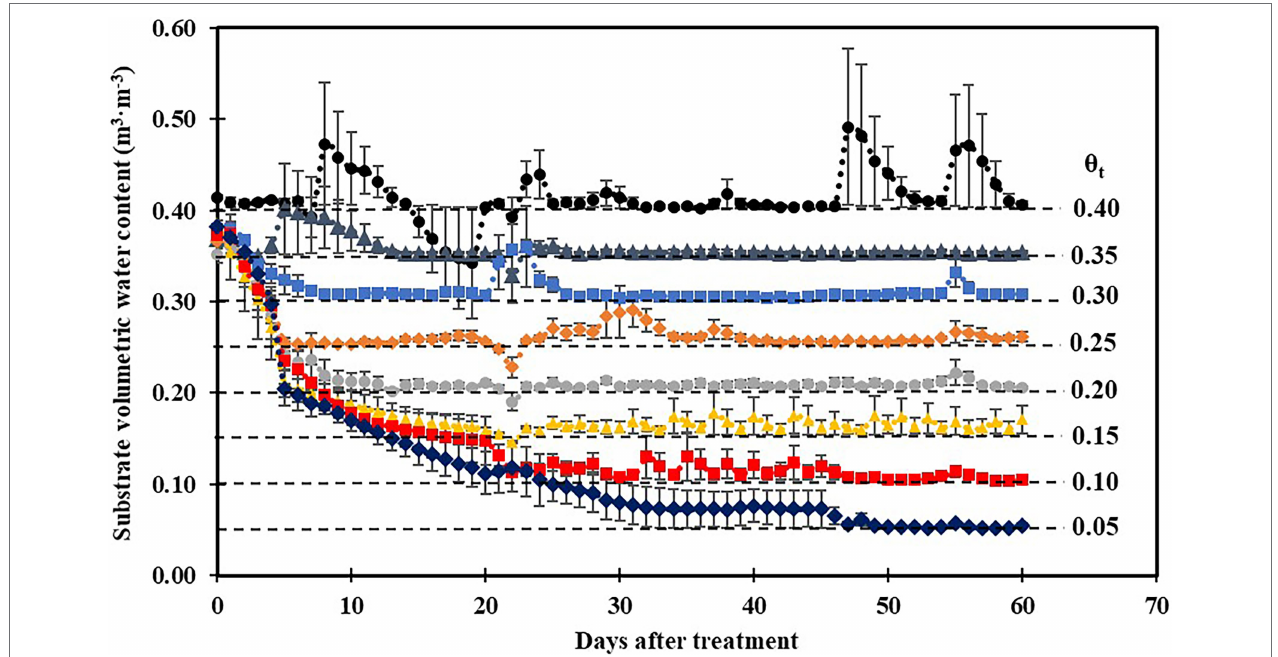
FIGURE 1 | Daily average substrate volumetric water content at eight substrate volumetric water content treatments ( θ t ) recorded using calibrated soil moisture sensors (ECH 2 O 10HS; Meter Group, Pullman, WA) during the experiment. Error bars represent SEs of three sensors.